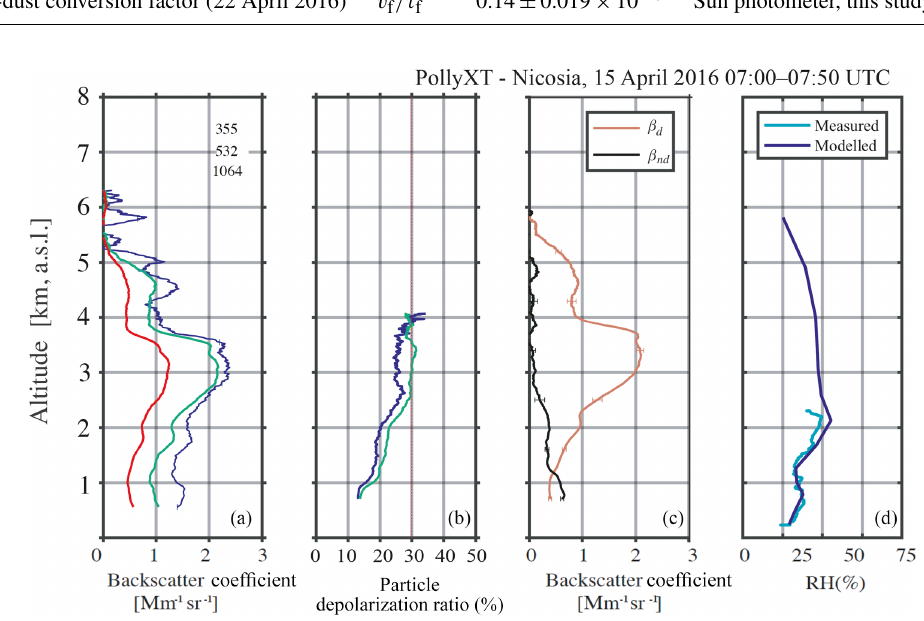
Figure 7. Daytime profiles of β (355, 532 and 1064nm wavelength) (a) , δ p (355 and 532nm wavelength) (b) , β d and β nd (c) determined by POLIPHON, as well as RH profiles from in situ measurements on board the UAV and from WRF-ARW model simulations over Nicosia at 08:00UTC (d)